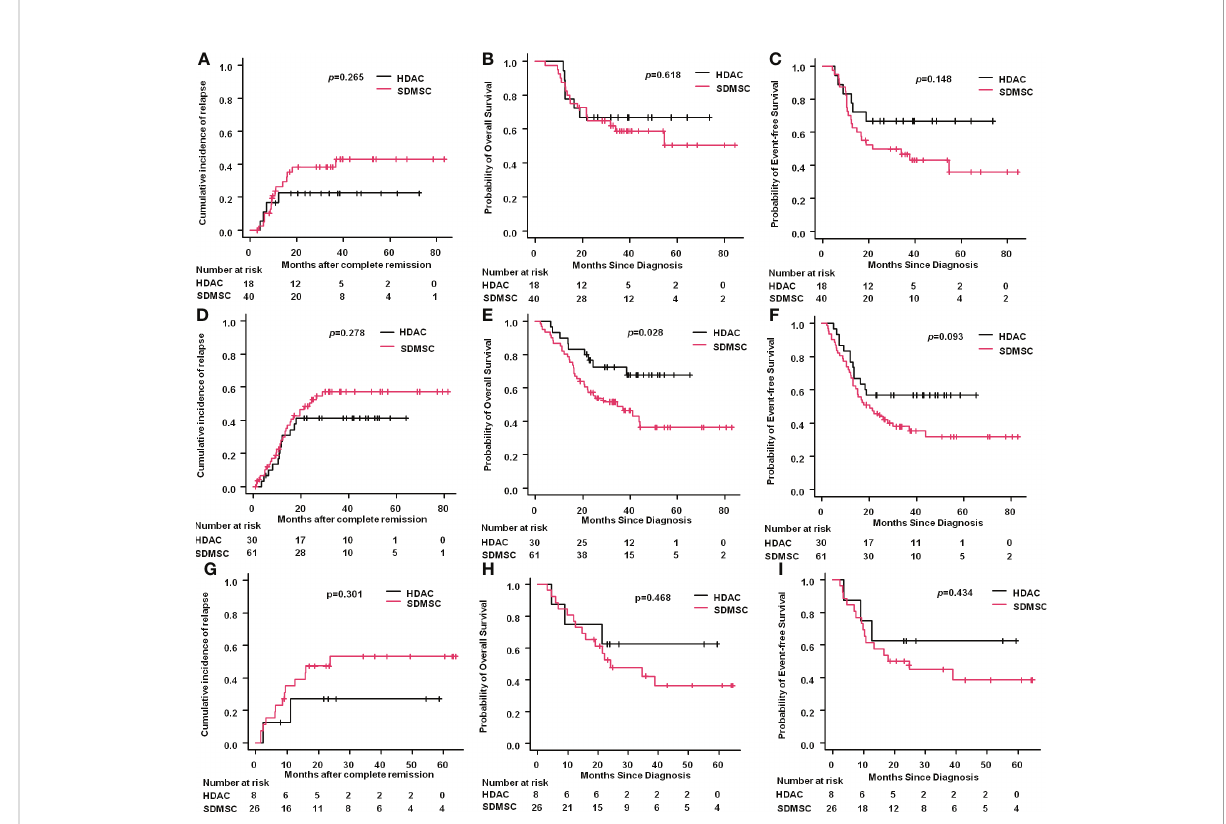
FIGURE 3 Results according to 2022 ELN risk strati fi cation. Cumulative incidence of relapse for favourable-risk patients (A) . Probability of overall survival for favourable-risk patients (B) . Probability of event-free survival for favourable-risk patients (C) . Cumulative incidence of relapse for intermediate-risk patients (D) . Probability of overall survival for intermediate-risk patients (E) . Probability of event-free survival for intermediate- risk patients (F) . Cumulative incidence of relapse for adverse-risk patients (G) . Probability of overall survival for adverse-risk patients (H) . Probability of event-free survival for adverse-risk patients (I)